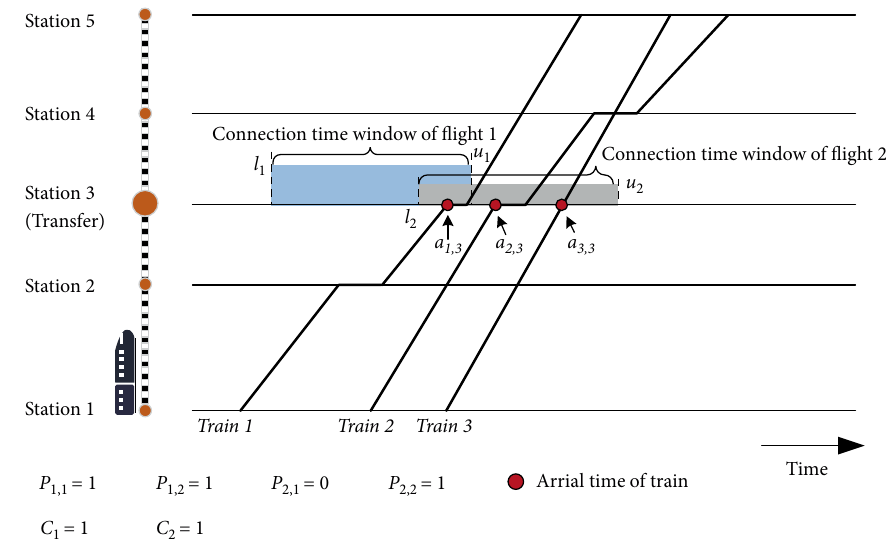
Figure 3: Illustration of a train timetable based on an AH integration